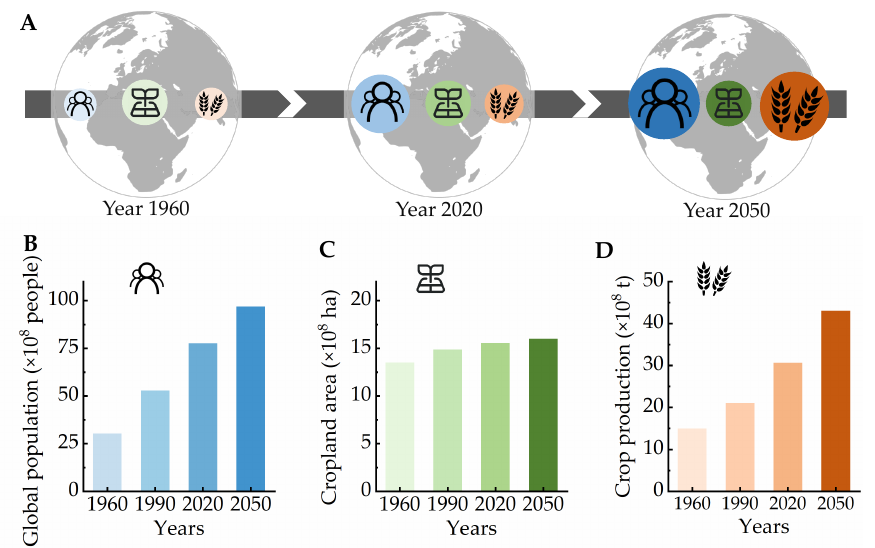
Figure 1. Variation in the global population, cropland area, and crop production from 1960 to 2050. ( A ) Past (1960), present (2020), and future (2050) estimates of global population, cropland area, and crop production. With the world population continuously growing and cropland area remaining largely unchanged, crop production must increase to fulfill the basic needs of the global population. Making full use of limited space is an effective way to improve the crop yield. ( B – D ) Estimated global population, global cropland area, and global crop production for the 1960–2050 period. To fully meet the needs of 10 billion people, crop production should increase by 50% on the available land by 2050. The global population data were obtained from the World Bank (https: //databank.worldbank.org/home.aspx, accessed on 7 January 2022); the cropland area and crop production data were downloaded from the FAO website (https://www.fao.org/faostat/en/#data, accessed on 7 January